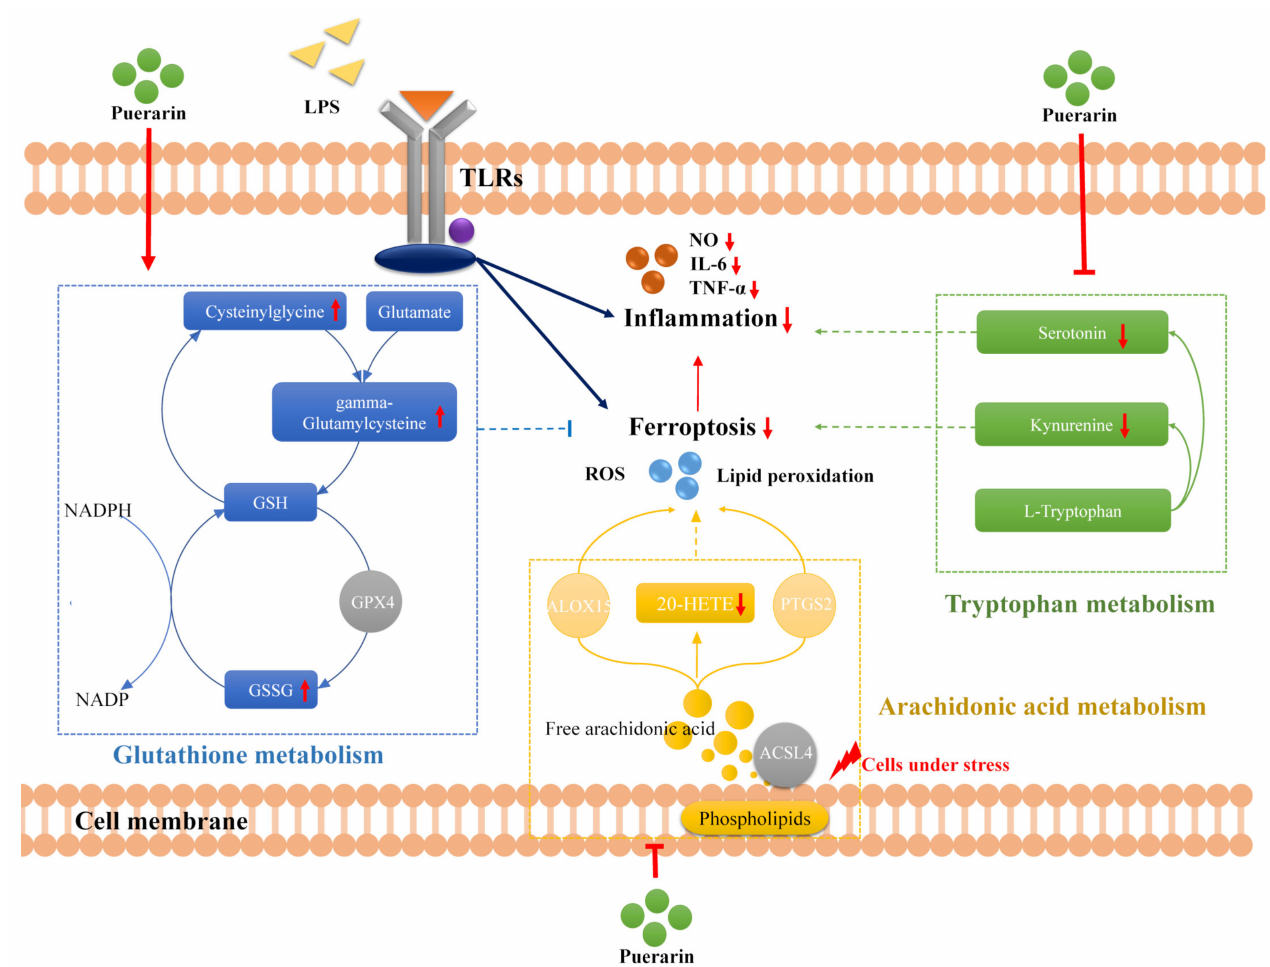
Figure 6. Hypothetical anti-inflammatory molecular mechanisms of puerarin by regulating ferrop- tosis. Rectangles represent metabolites and circles represent enzymes. Gray circles represent the biomarkers of ferroptosis. Lines with arrow-heads represent activation and lines with bars at the end denote